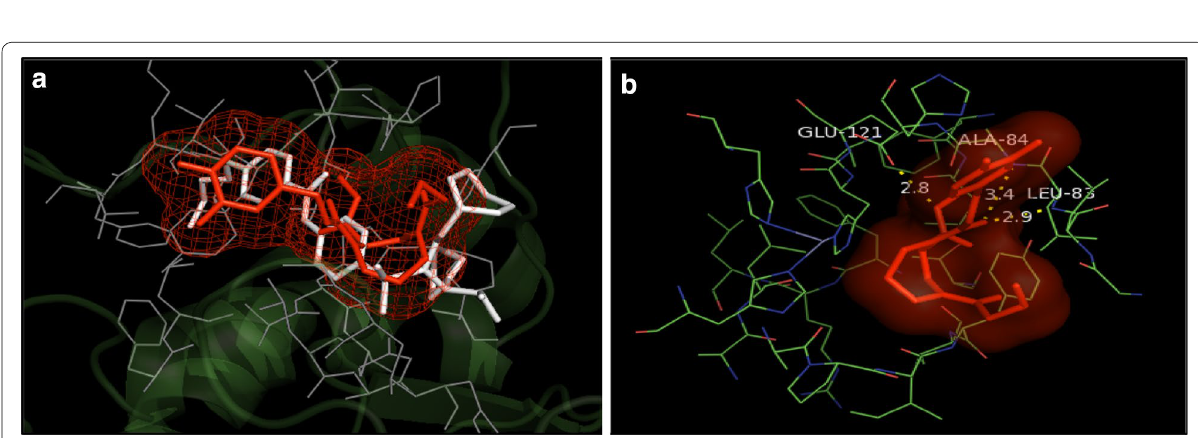
Fig. 7 a Overlay of the docked pose of compound 16 (red) with that of PDB Ligand 1HOV (white); b docked pose: H-bond interaction of com- pound 16 in the binding site of MMP-2